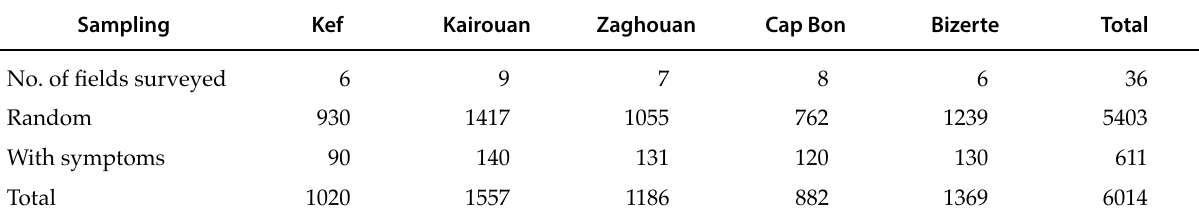
Table 1. Location and number of barley samples collected from 36 fields in different regions in Tunisia in April 2012.